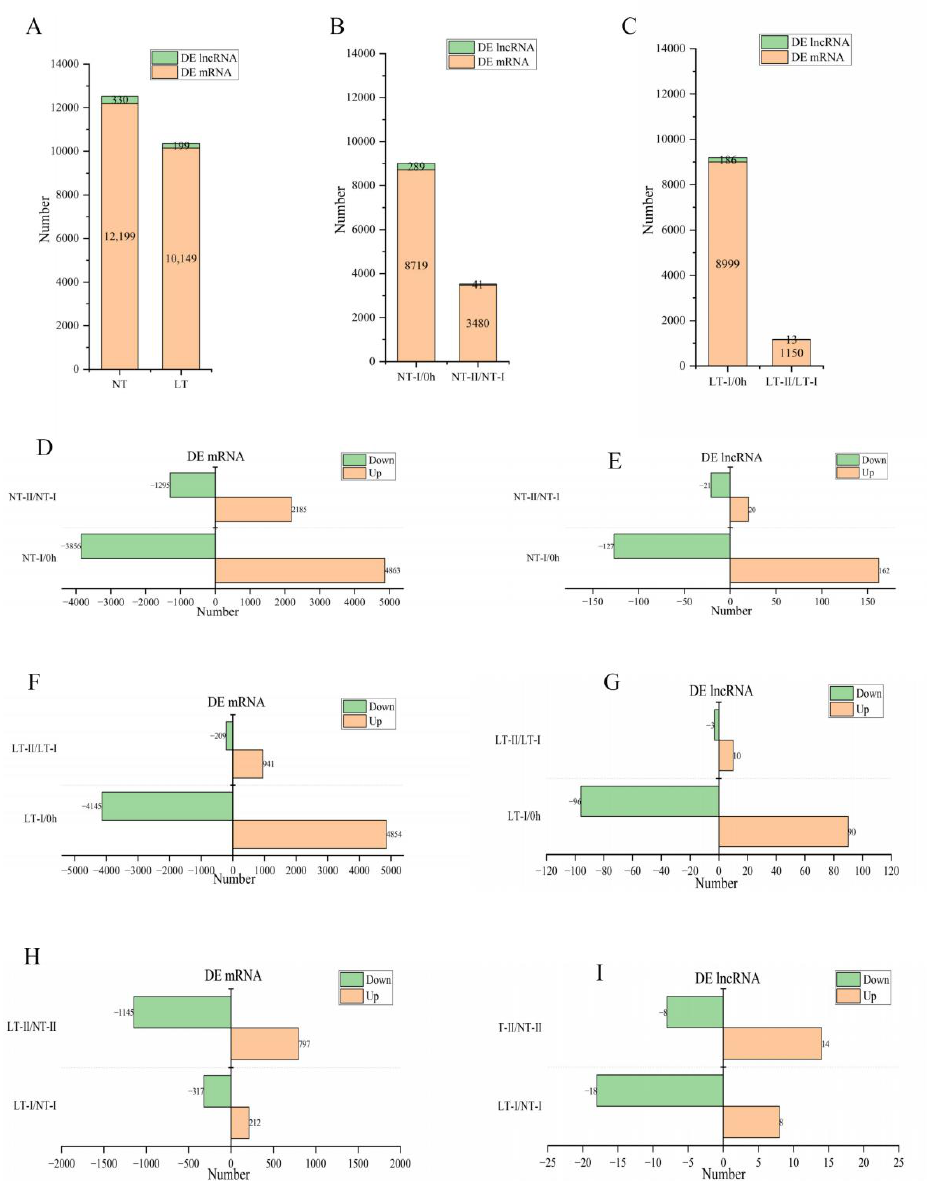
Figure 5. DE lncRNAs and DE mRNAs at different stages of NT and LT. ( A ) Number of total DE transcripts under NT and LT treatments. ( B ) Number of DE lncRNAs and DE mRNAs under NT treatments. ( C ) Number of DE lncRNAs and DE mRNAs under LT treatments. ( D ) Number of up- regulated and downregulated DE mRNAs under NT treatments. ( E ) Number of upregulated and downregulated DE lncRNAs under NT treatments. ( F ) Number of upregulated and downregulated DE mRNAs under LT treatments. ( G ) Number of upregulated and downregulated DE lncRNAs under LT treatments. ( H ) Upregulated and downregulated DE mRNAs in LT-I/NT-I and LT-II/NT- II. ( I ), Upregulated and downregulated DE lncRNAs in LT-I/NT-I and